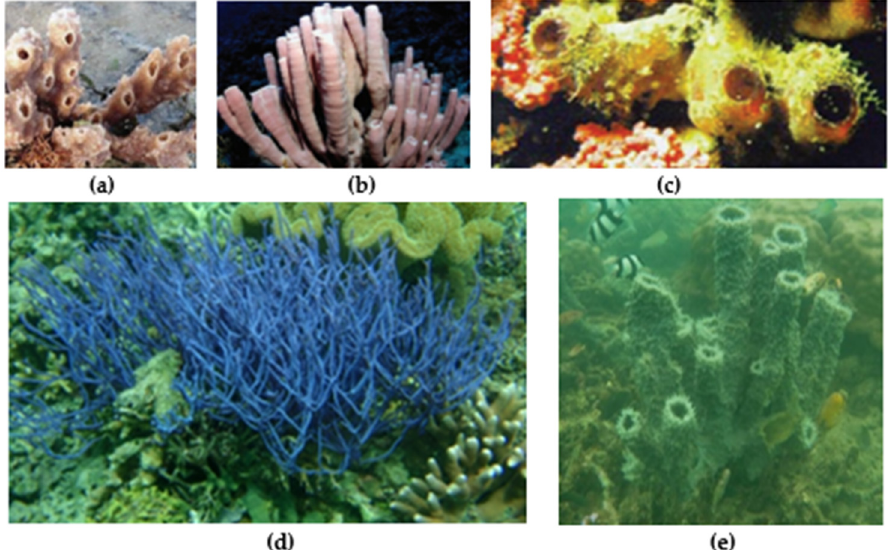
Figure 1. ( a ) Callyspongia diffusa , ( b ) Callyspongia siphonella , ( c ) Callyspongia truncata [15], ( d )